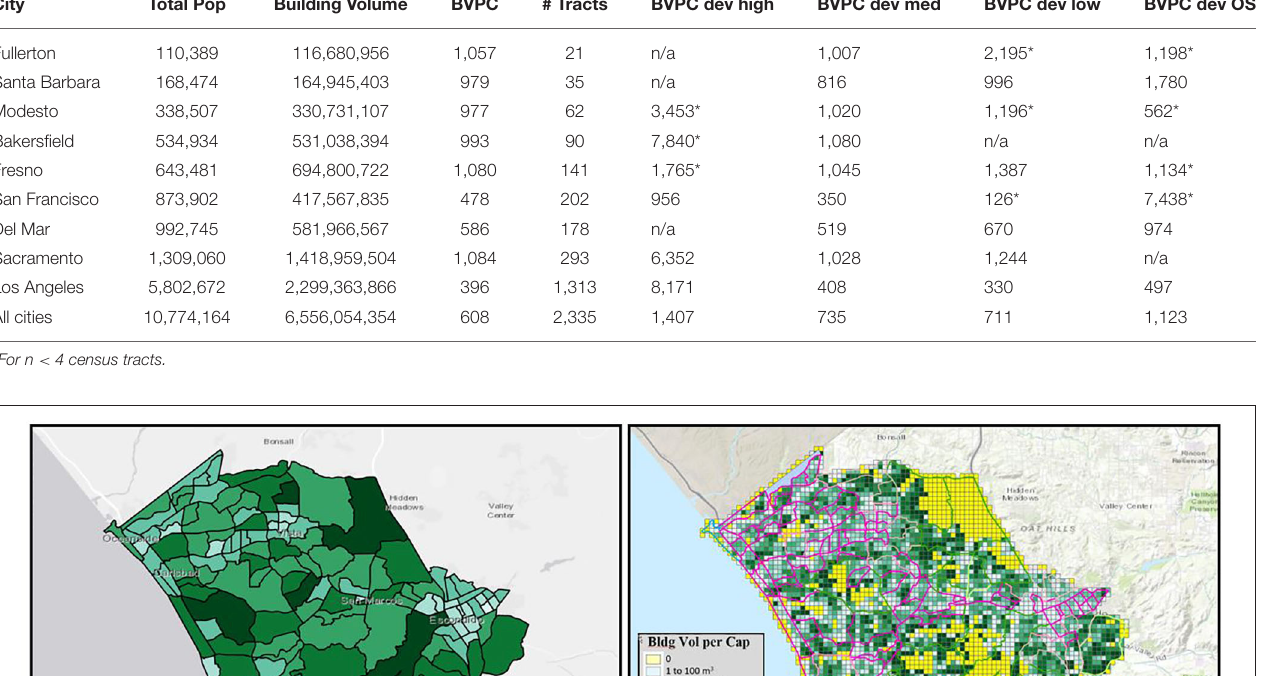
addition, we characterized the mean and variability of the BVPC for those tracts according to their NLCD majorities. We also